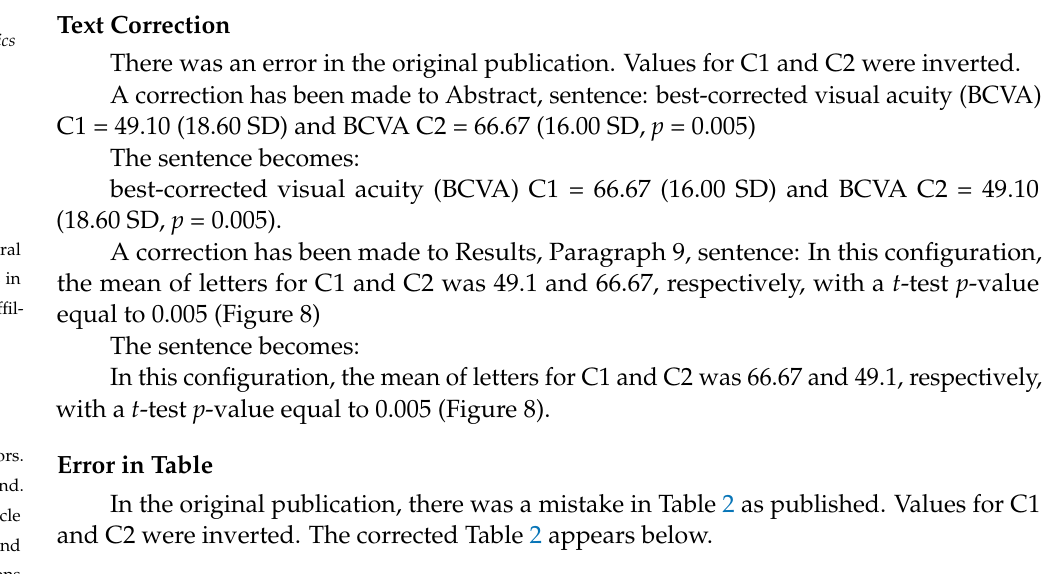
Figure 8 legend